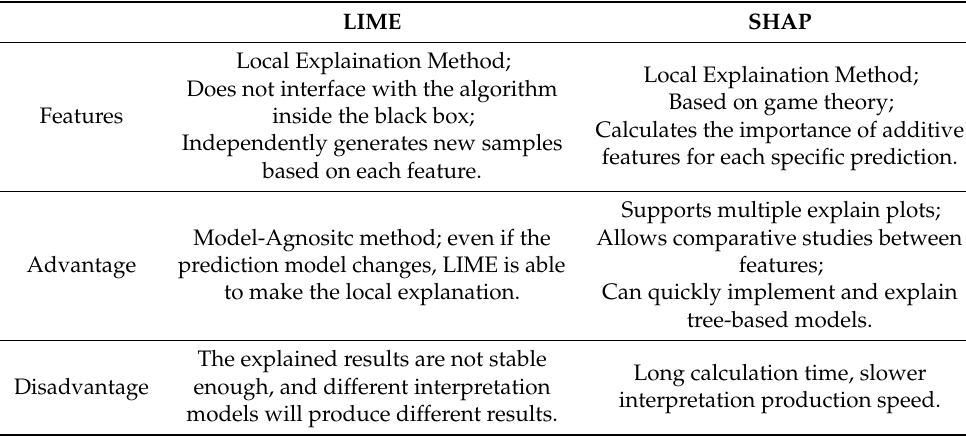
Table 1. The features and differences between LIME and